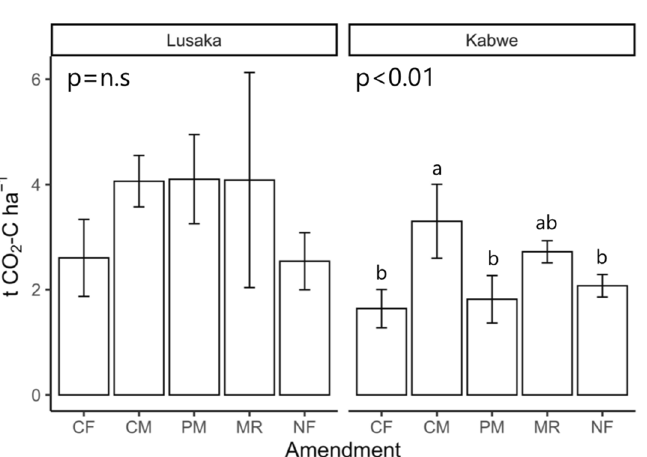
Figure 2. Temporal changes in the CO 2 emission rate at the ( a ) Lusaka and ( b ) Kabwe sites. Different shapes represent the different fertilizer treatments. The levels of significance at the top of the panels were based on mixed model results for repeated measurements. Error bars represent the standard deviation of the mean ( n = 3). CF: chemical fertilizer treatment, CM: cattle manure treatment, PM: poultry manure treatment, MR: maize residue treatment, and NF: no fertilizer treatment.